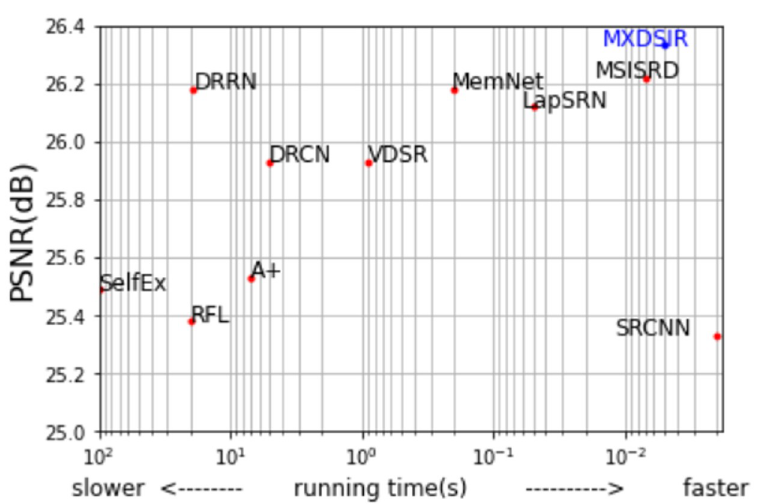
Fig 11. Quantitative comparison between the PSNR [81] performance vs. runtime on Set5 [84] scale 8 × enlargement.